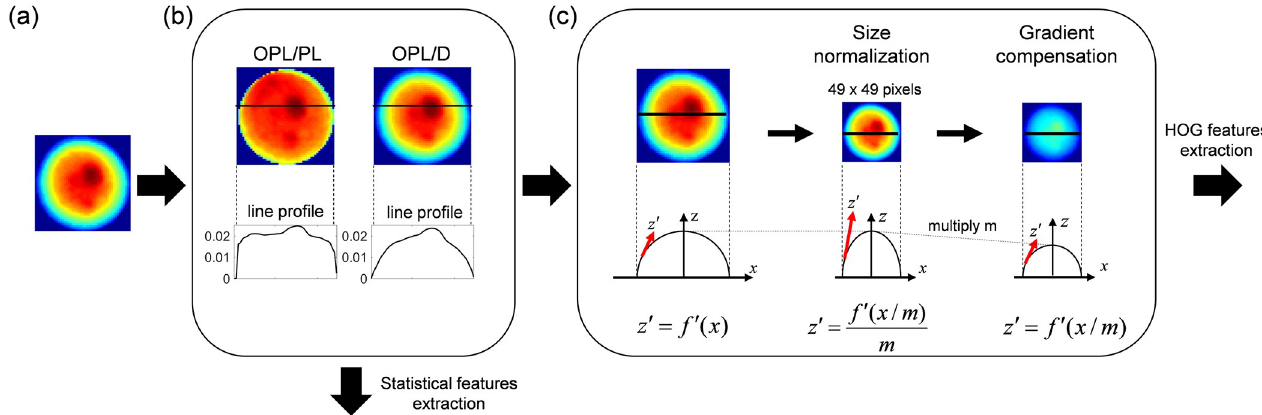
Fig 4. Two-branch flowchart of preprocessing for size-invariant feature extraction for statistical- and HOG-based subcellular classification. (a) Segmented image of a cell. (b) OPL normalizations by path length (PL) or diameter (D). Line profiles along the black lines in the pseudo color images of OPL/ PL or OPL/D are shown for comparison of two normalizations. The details of subcellular structure are unclear in the profile of OPL/D because of spatial low frequency components (the hemisphere), whereas the details of intracellular structure are recognized in the flat region of the profile of OPL/PL. (c) Size normalization and gradient compensation. Function f represents the profile of OPL/D or OPL/PL. Red arrows represent the spatial gradients of f (i.e., f 0 ). The gradients were divided by resize factor m for compensations.